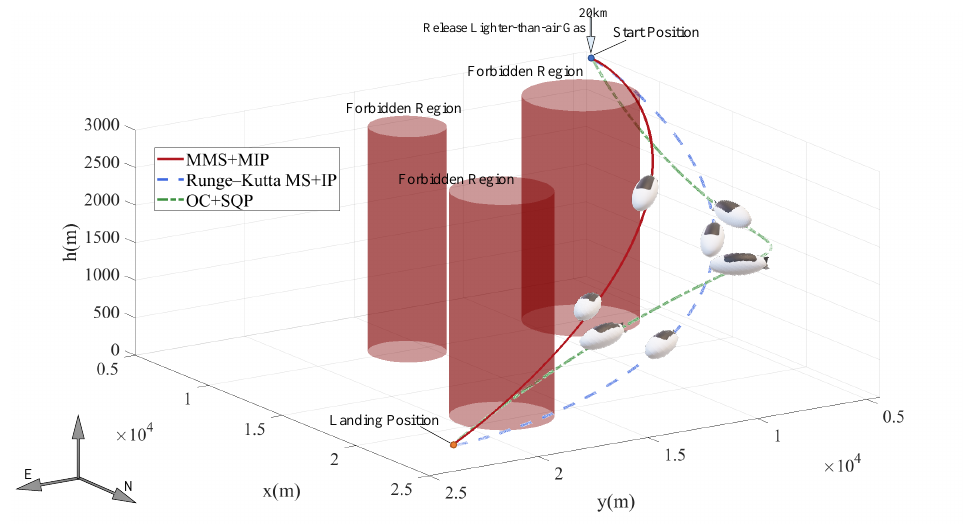
Figure 12. Three-dimensional schematic diagram of different methods.